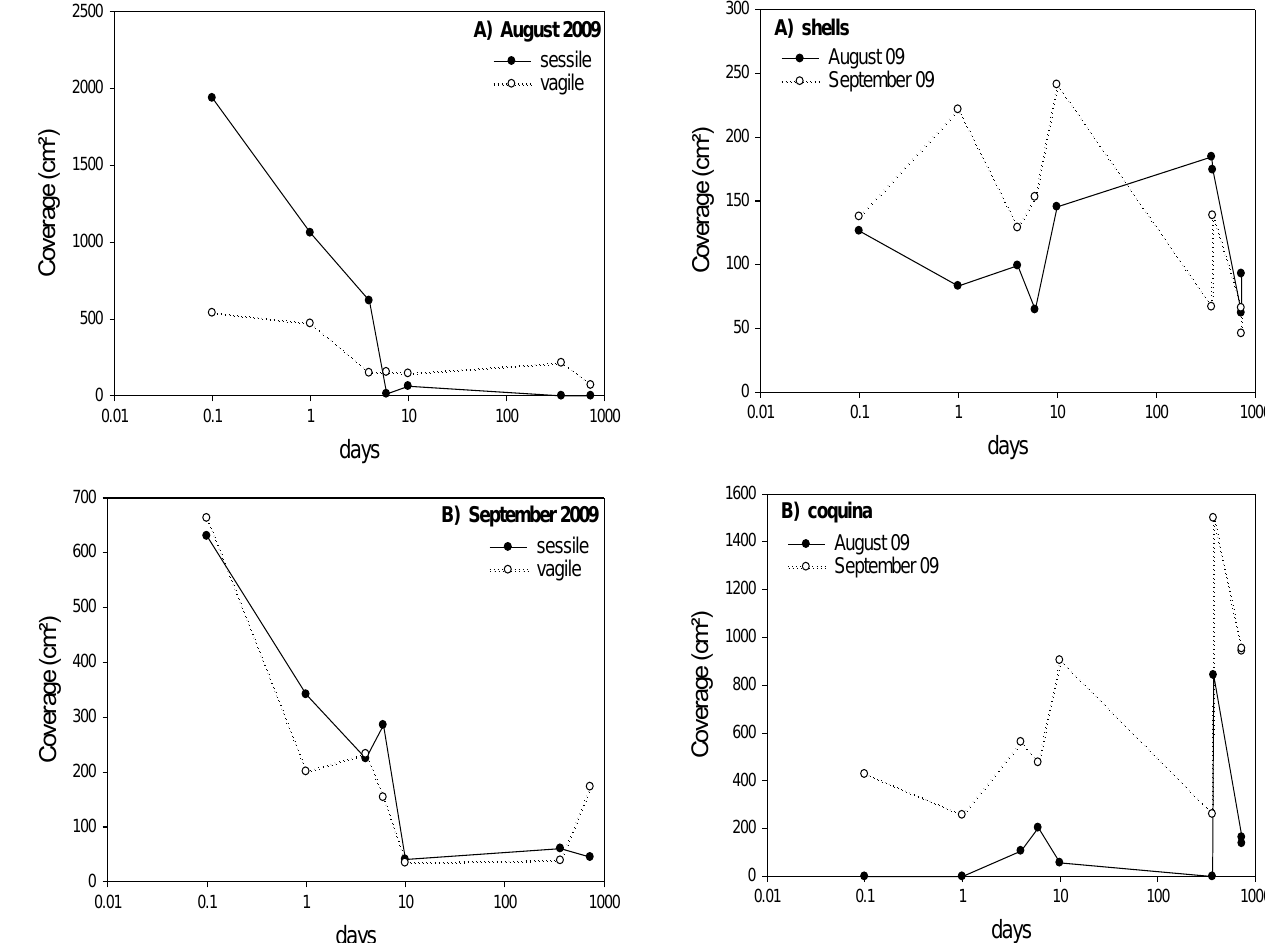
Figure 5: Coverage of sessile (dead and living) and vagile fauna after anoxia in the August 2009 876 (above) and September 2009 (below) plot. Note different scales on y-axis. Start of experiment 877 Fig. 5. Coverage of sessile (dead and living) and vagile fauna after defined as 0.1; values measured inside closed chamber (original coverage). 878 anoxia in the August 2009 (above) and September 2009 (below) 879 plot. Note different scales on y axis. Start of experiment defined as 0.1; values measured inside closed chamber (original coverage).